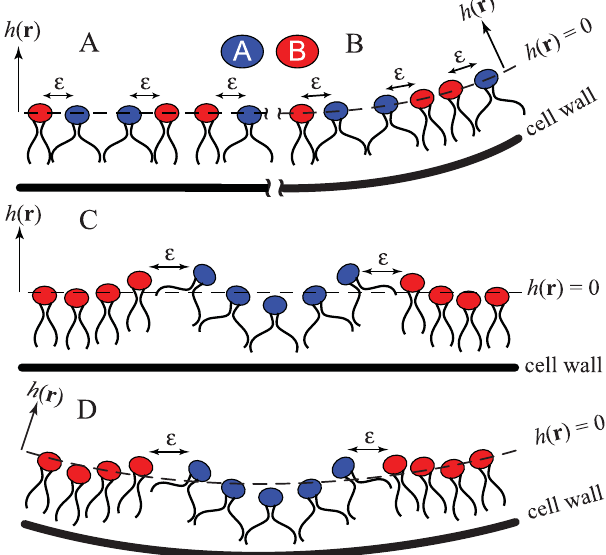
Figure 1. Schematic of Lipid Clustering in Different Membrane Configurations (A) A homogeneous mixture of two lipid components (type A in blue, B in red) has a high energy because of the abundance of unlike nearest- neighbor pairs, each contributing an energy e (see Materials and Methods). (B) Same as (A), except the cell wall has higher curvature; this results in a slight reduction in the energy of lipids of type A, which have higher intrinsic curvature. (C) A cluster of lipids of type A is accompanied by membrane curvature ( r 2 h ( r )). Though the elastic energy of the membrane increases relative to (A), the formation of clusters eliminates unlike nearest-neighbor pairs and so reduces the total energy. (D) The same configuration in (C) shifted to a region of cell wall with higher curvature experiences a large reduction in energy, leading to cluster localization at the poles.